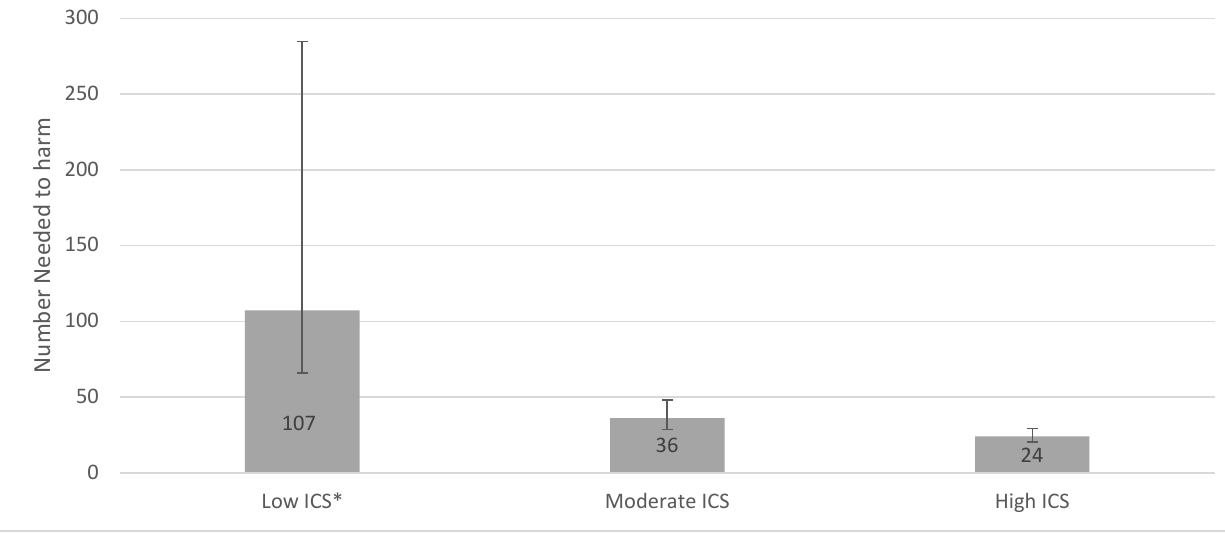
Figure 4. Number needed to harm for low, moderate, and high ICS use. ICS exposure was calculated by the accumulated dose of ICS prescriptions reimbursed within 365 days prior to study entry. The accumulated dose was divided into tertiles of low, moderate, and high ICS dose, with non-users as the reference group. The NNH for the three groups: Low ICS (NNH 107, 95% CI 66.1–284.7), Moderate ICS (NNH 36 95% CI 28.8–48.4), and High ICS (NNH 24, 95% CI 20.3–29.4). * There